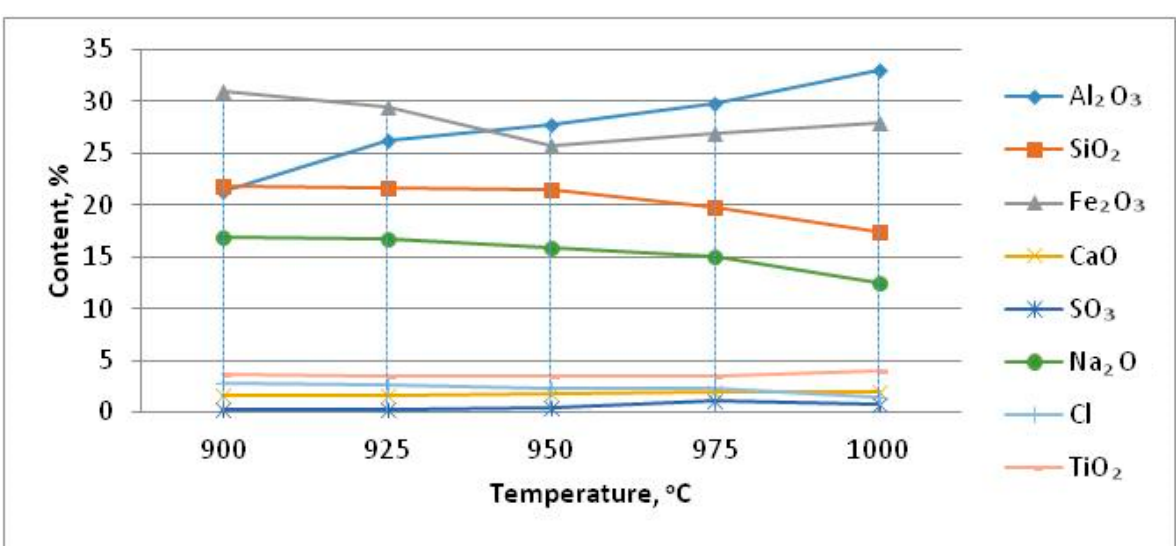
Figure 12. The compositions of aluminate solutions. Analysis of the autoclave leaching results for pre-calcined bauxite showed that the optimal conditions are the roasting temperatures of bauxite 950–975 ◦ C, while the alumina extraction into the solution was 87.8–88.1%. A higher roasting temperature resulted in an increase in the proportion of the sparingly soluble Al 2 O 3 phase, respectively, to a decrease in